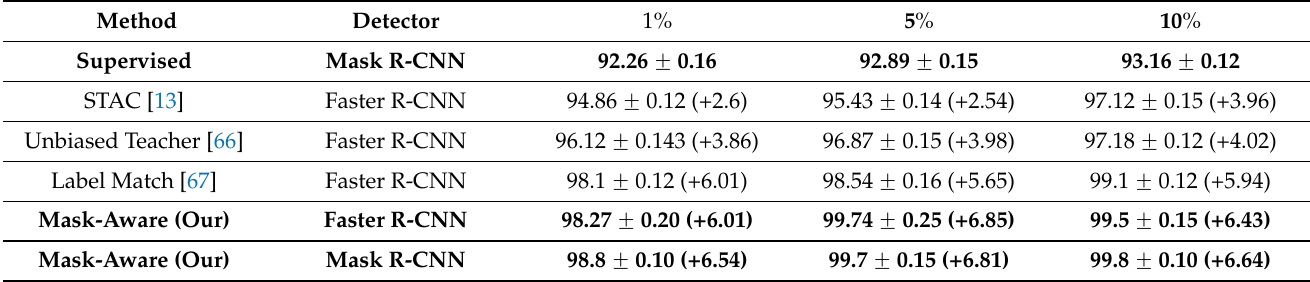
Table 4. Previously comared semi-supervised detectors with our approach trained on an average of 5 data folds with 1%, 5%, and 10% SFPI label dataset.